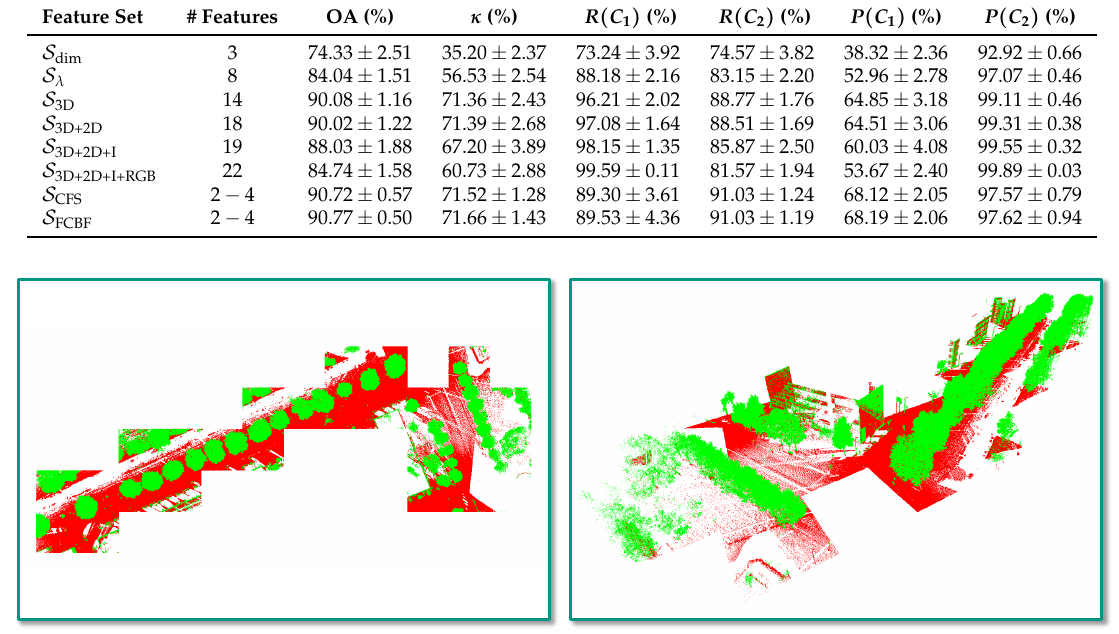
Figure 5. Visualization of a classification result derived with the feature set S 3D+2D comprising 18 low-level geometric 3D and 2D features ( left : nadir view; right : side view): those 3D points categorized as “tree points” are colored in green, whereas those 3D points categorized as “other points” are colored in red (the classification result corresponds to an overall accuracy of 90.07% and a kappa value of 71.54%).